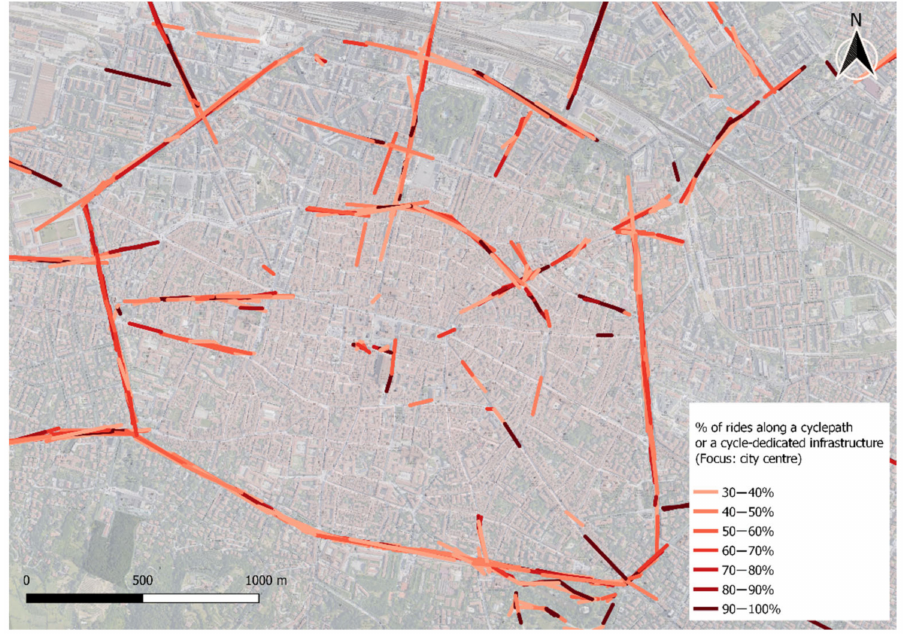
Figure 9. Distribution of sections of trips ridden at least 30% of their length along cycle-dedicated